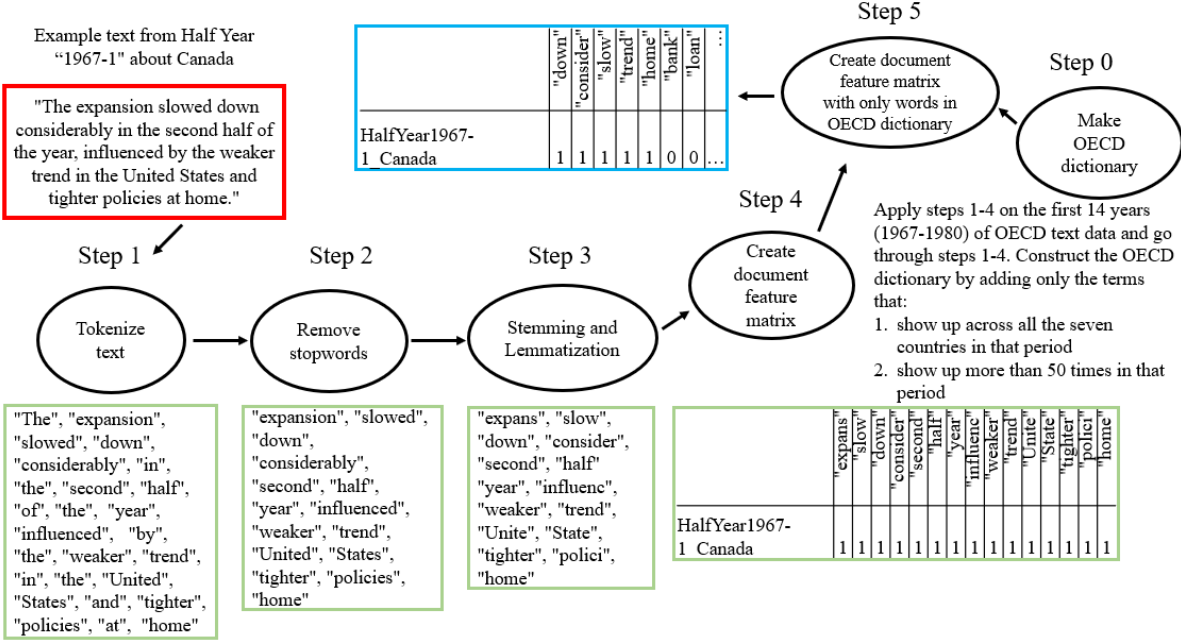
Figure 5. Text Data Setup . Note: This figure describes the process of cleaning the textual data, demonstrating the process on a sentence from Canada’s entry in the OECD Economic Outlook, Volume 1967, Issue 1. As a preliminary step, we create an OECD dictionary based on OECD text data by removing the most and least frequently used terms in the OECD Economic Outlook text source from 1967 to 1980; this leaves us with 881 terms, comprising unigrams and bigrams (for simplicity, the figure only shows unigrams) that exist throughout the sample, thereby minimizing look-ahead bias. For the documents of each of the text sources (OECD, RDNF, IMF Article IVs), we tokenize the text, remove common English stop words, stem and lemmatize the text, and create a document feature matrix. We then create a subset of the words in the OECD dictionary to construct our final document feature matrix for each text